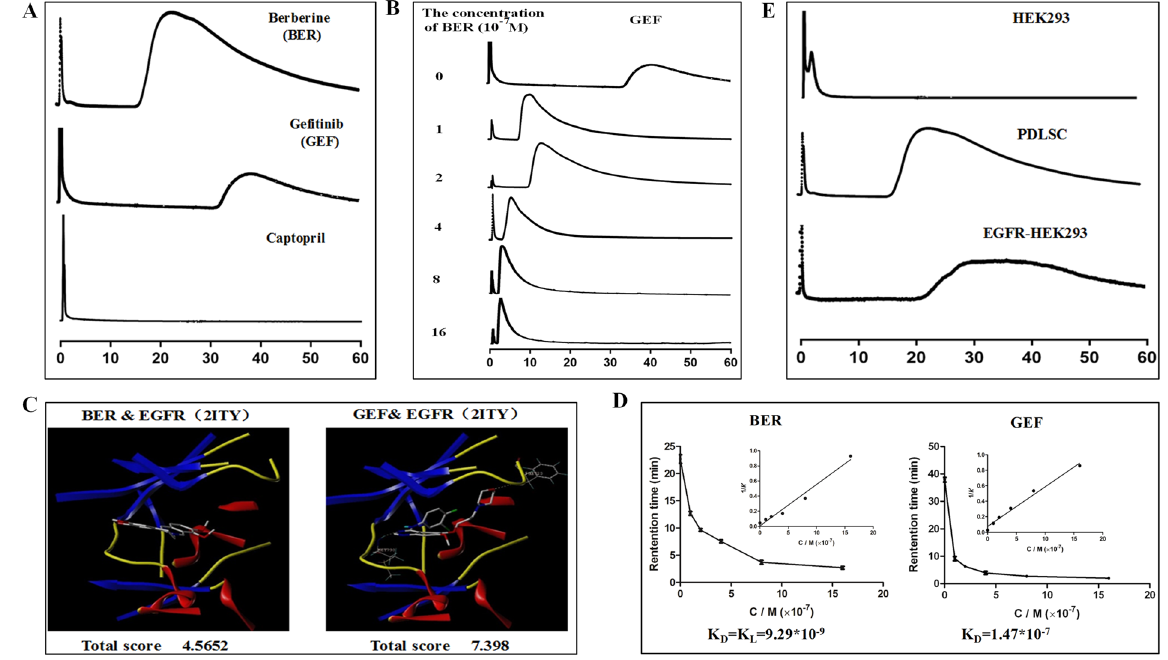
Figure 2. Screening the possible membrane receptor of BER activity binding to the hPDLSC. The situation of retention for different receptor antagonists ( A ) and competitions with BER on hPDLSC-CMC ( B ); Molecular docking experiments and interactions between Gefitinib and BER with cell membrane receptor ( C,D ); The retention times of BER in different CMC established with 3 cells (HEK293, hPDLSC and EGFR-HEK293) ( E